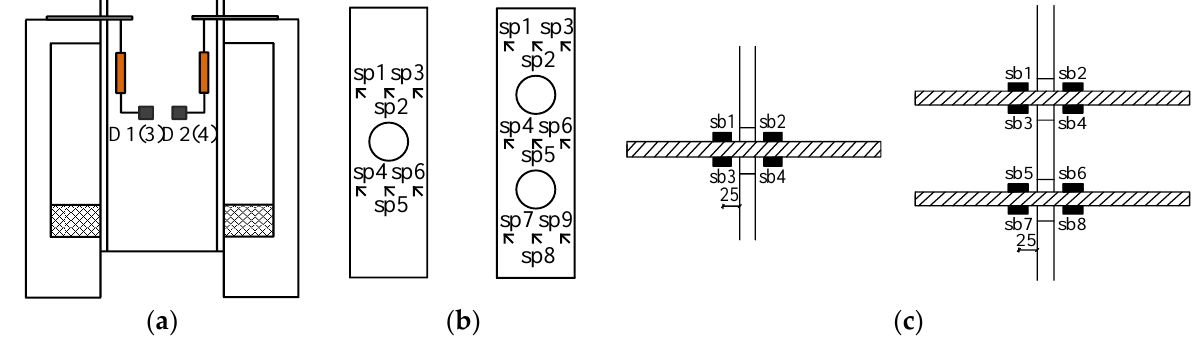
Figure 6. Instrumentation arrangement of push-out specimens (units: mm) : ( a ) Layout of dial indicator; ( b ) Strain-gauge arrangement of perfobond rib; ( c ) Strain-gauge arrangement of perforating rebar.